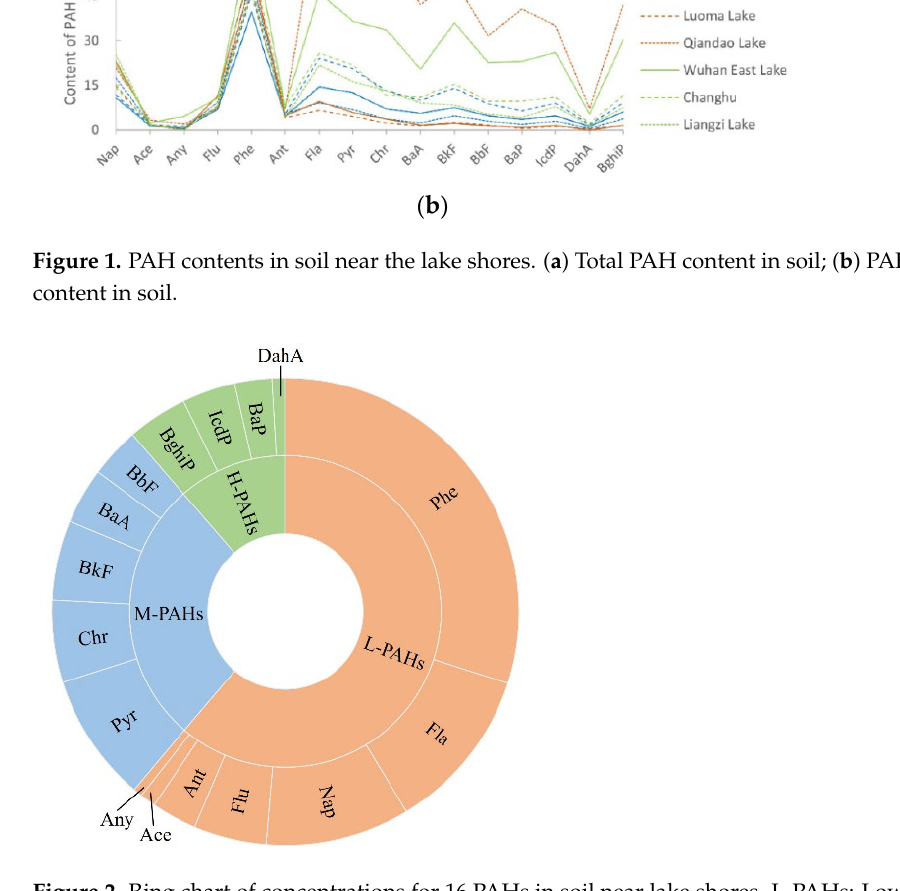
Figure 2. Ring chart of concentrations for 16 PAHs in soil near lake shores. L-PAHs: Low-molecular-weight PAHs. M-PAHs: Medium-molecular-weight PAHs. H-PAHs: High-molecular-weight PAHs. For soil samples from different lakes, the PAHs in the soil near Qiandao Lake were dominated by medium-molecular-weight PAHs, which accounted for 46.6% of the total PAHs, followed by low- and high-molecular-weight PAHs. Low-molecular-weight and medium-molecular-weight PAHs were the main PAHs in the soil of Wuhan East